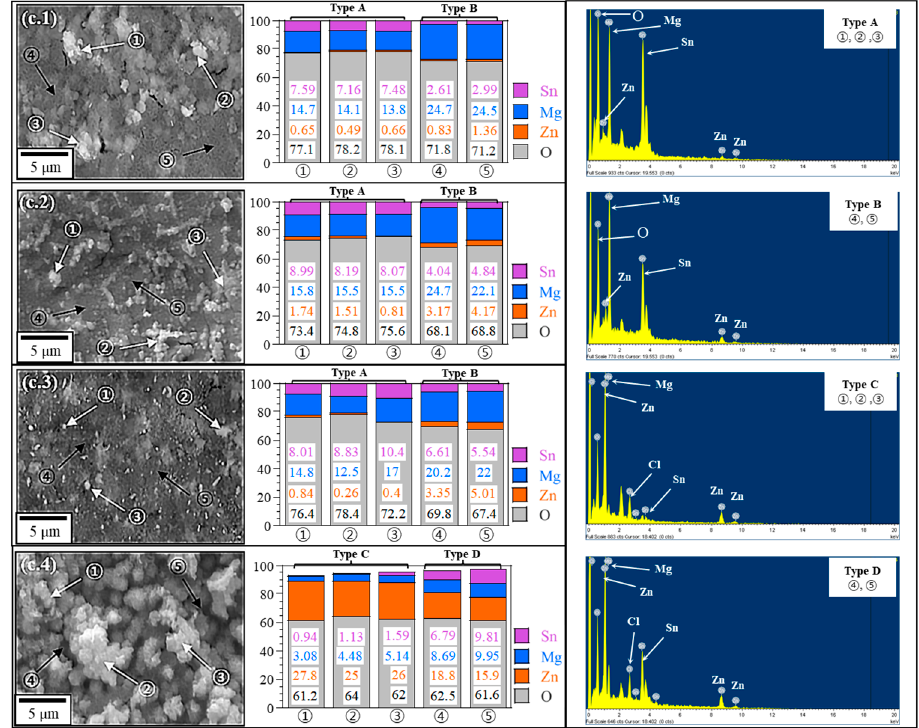
Figure 8. SEM images and EDS components at four different points in Figure 7c. The white arrows indicate the location of the white precipitates and the black arrows indicate the matrix. The bar graphs display the composition of arrows from 1 to 5 at left SEM images. The compositions are categorized to four different types from A to D in terms of SEM images and their